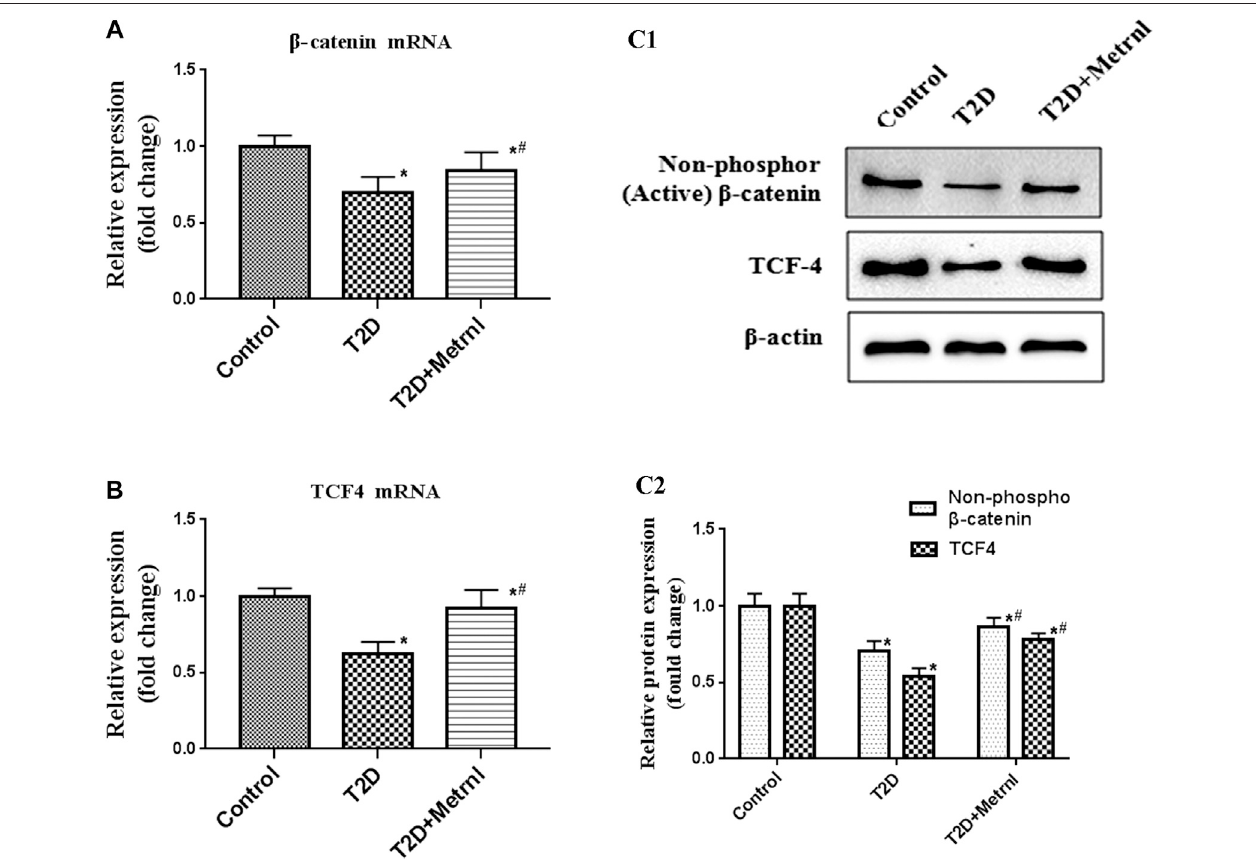
FIGURE9| TheexpressionofthemarkerproteinsofWNT/ β -cateninpathwayinthepancreatictissueofmicequanti fi edbyreal-timePCRandwesternblot. (A) The geneexpressionof β -cateninwasquanti fi edbyreal-timePCR.Dataarepresentedasthefoldchangeoftranscriptsforthetargetgeneintheindicatedgroupsnormalized to β -actin. (B) The gene expression of TCF4 was quanti fi ed by real-time PCR. Data are presented as the fold change of transcripts for the target gene in the indicated groups normalized to β -actin. (C) Representative western blot showing β -catenin and TCF4 protein levels in the pancreatic tissue of mice. Band densities were converted to a bar graph. All data are expressed as mean ± SEM [ n (cid:2) 8/group (mRNA), n (cid:2) 8/group (protein)]. * p < 0.05 for differences vs. control group; # p < 0.05 for differences vs. T2D group. T2D: type 2 diabetes.